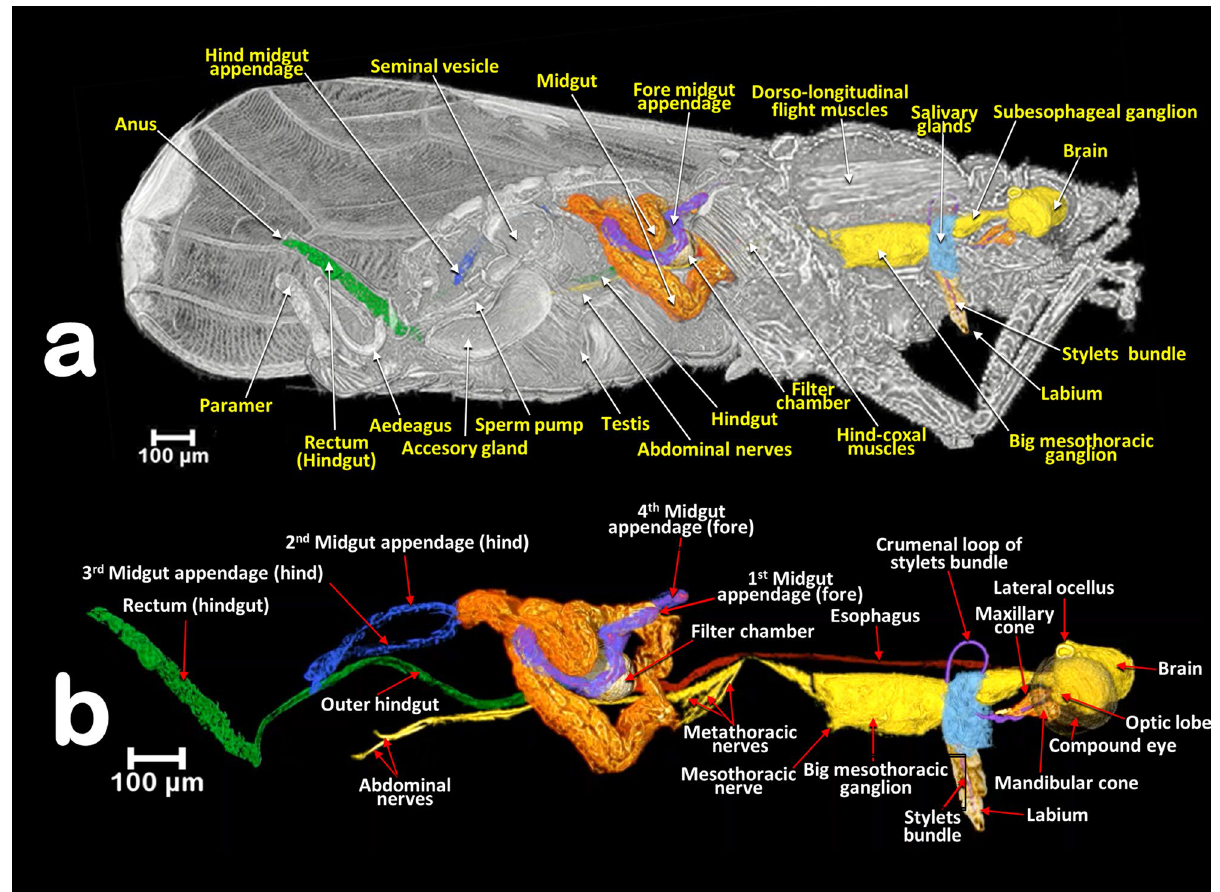
Figure 12. Volume-rendered images of a male Diaphorina citri in a right-lateral view, showing the feeding apparatus, the digestive system (including the salivary glands) and nervous system. Medial sagittal view ( a ). Isolated segmented organs and structures ( b